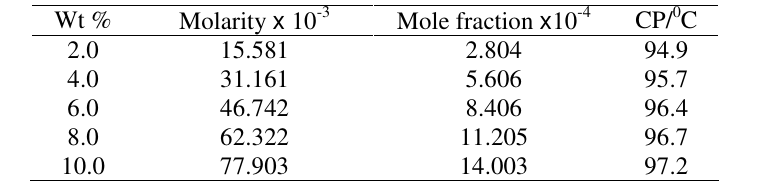
Table 1. Cloud points of pure Tween-40